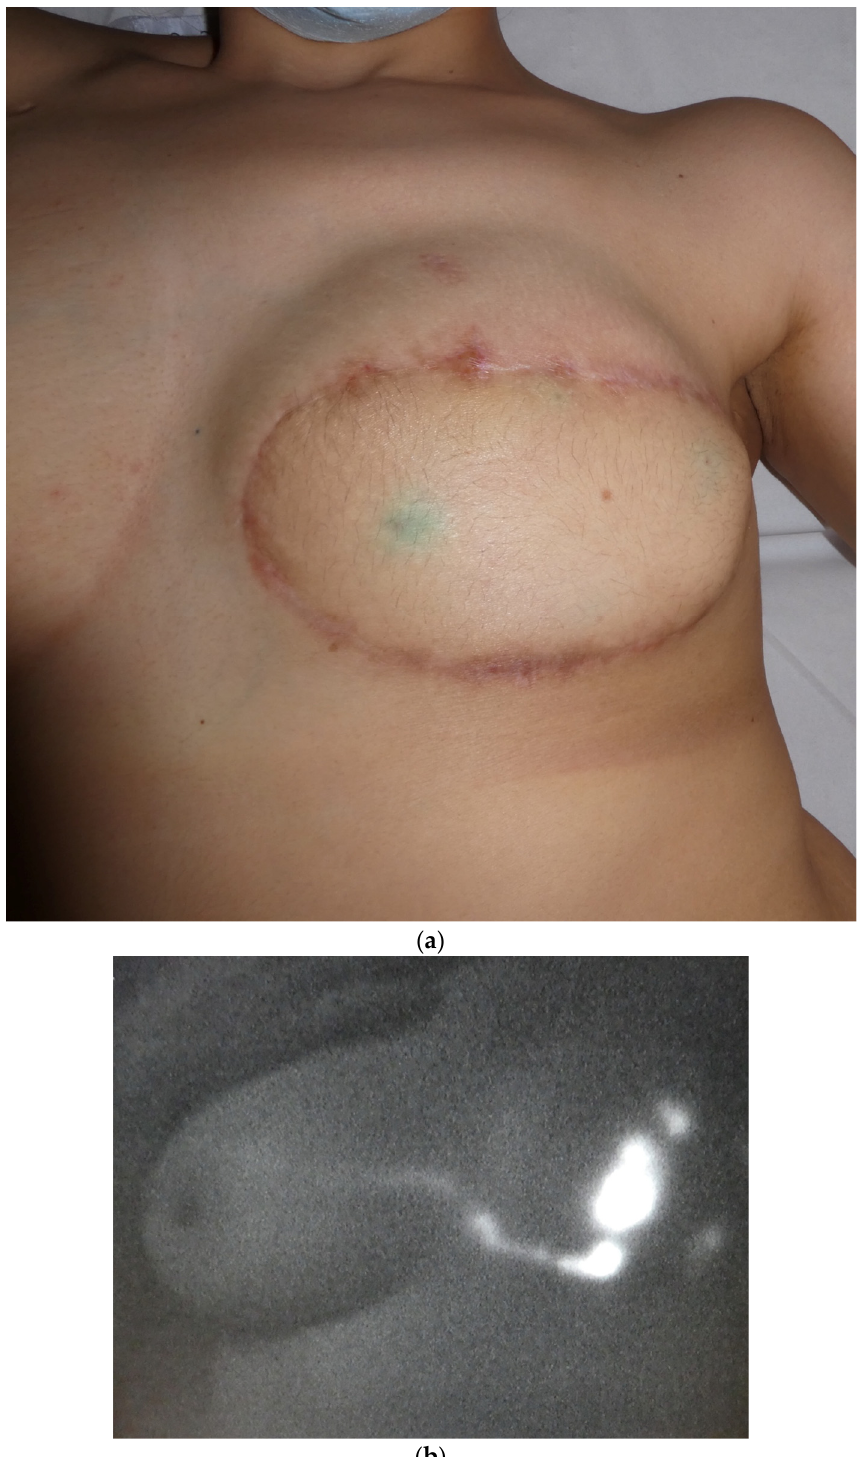
Figure 4. ( a ) Breast reconstruction with DIEP flap at one-year follow-up. ( b ) Breast reconstruction with DIEP flap and spontaneous lymph flow restoration at the one-year follow-up.